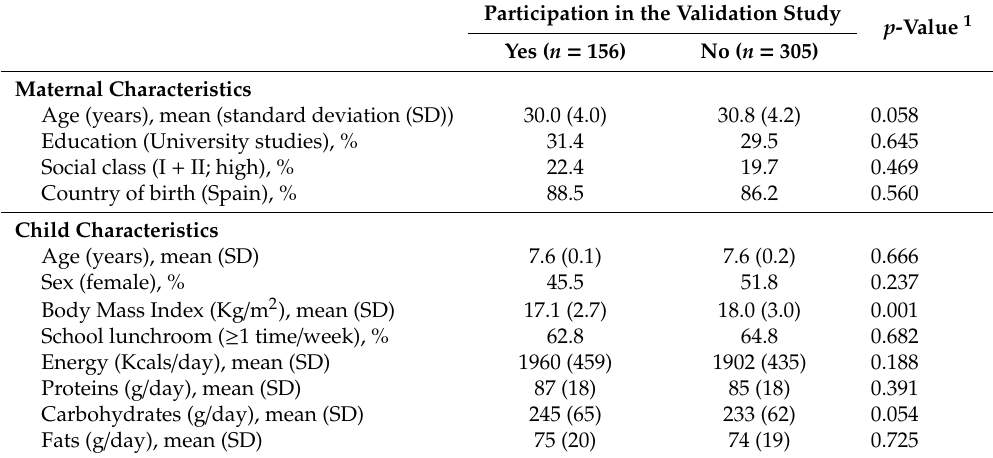
Table 2. Characteristics of children and their mothers who attended a 7–9 year follow up distinguishing between participants or no participants in the validation study (Yes / No) of the INMA-Valencia cohort study.